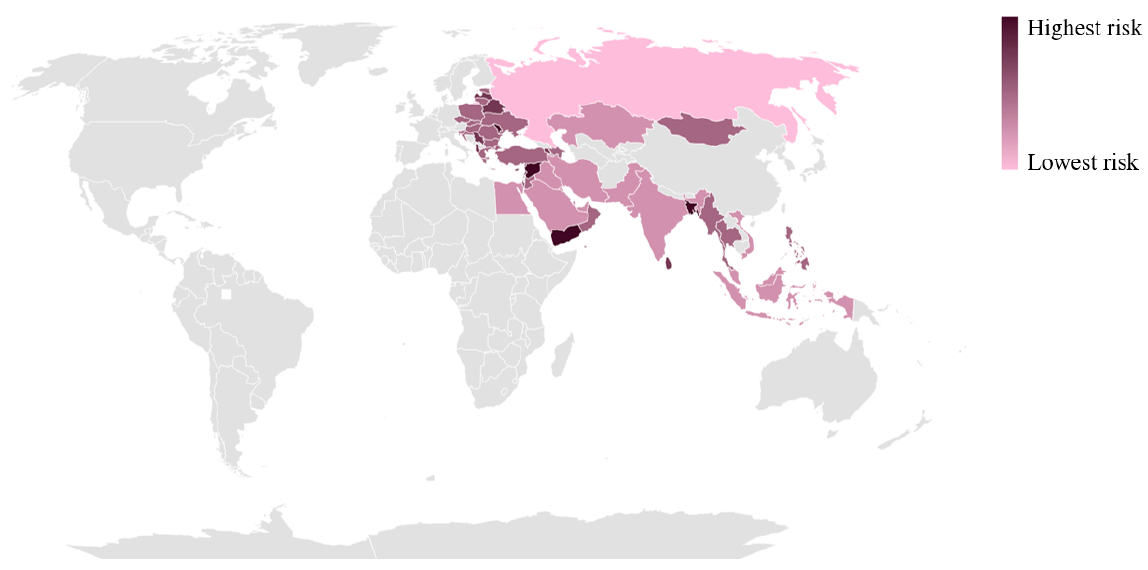
Figure 5. The results of the national investment risk evaluation based on 6-D evaluation.